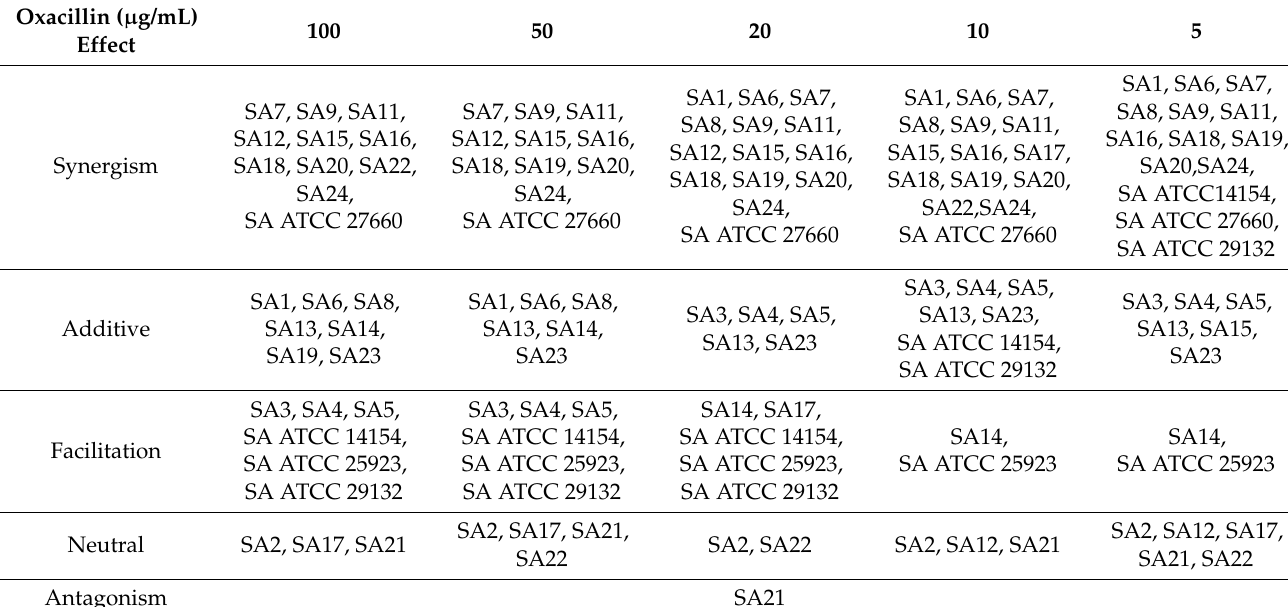
Table 1. List of S. aureus strains against which the phage Sb-1 (MOI = 0.1) interacted positively or negatively with oxacillin, depending on the antibiotic